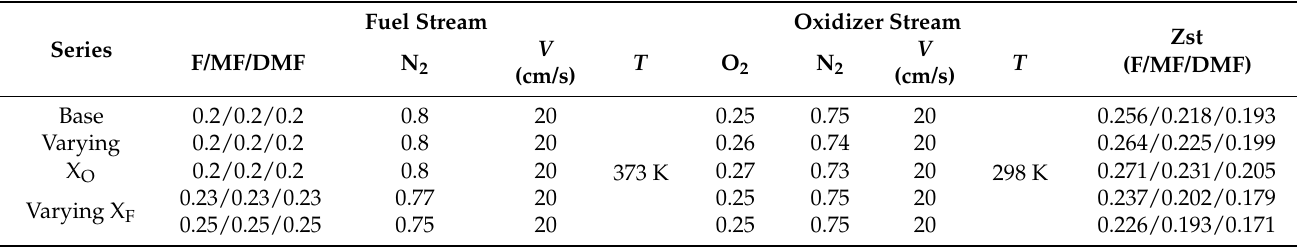
Table 1. Flame boundary conditions in this work. V is the fuel and oxidizer stream velocity, T is the temperature, and Z st is the stoichiometric mixture